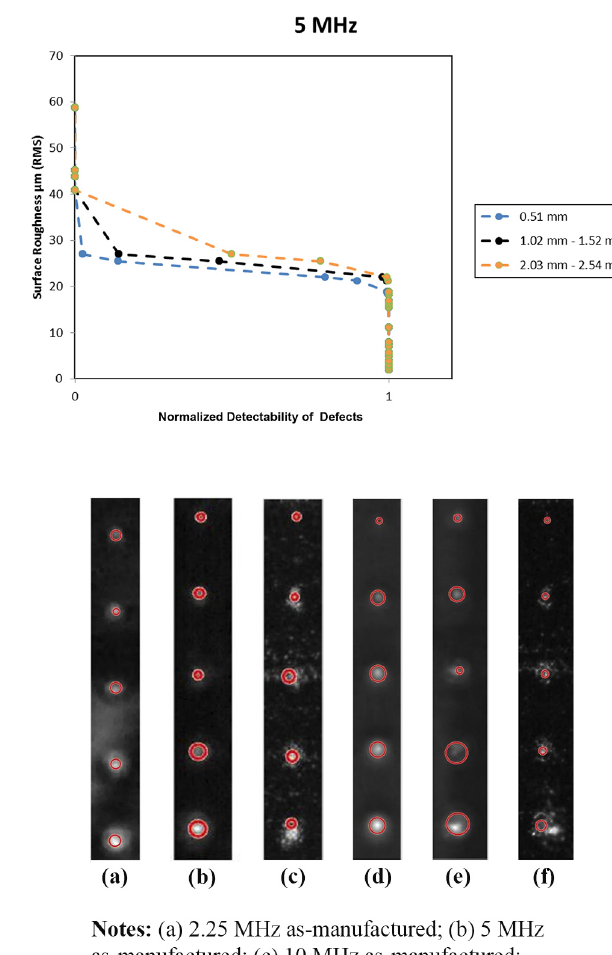
Figure 8. Sample A-41 top